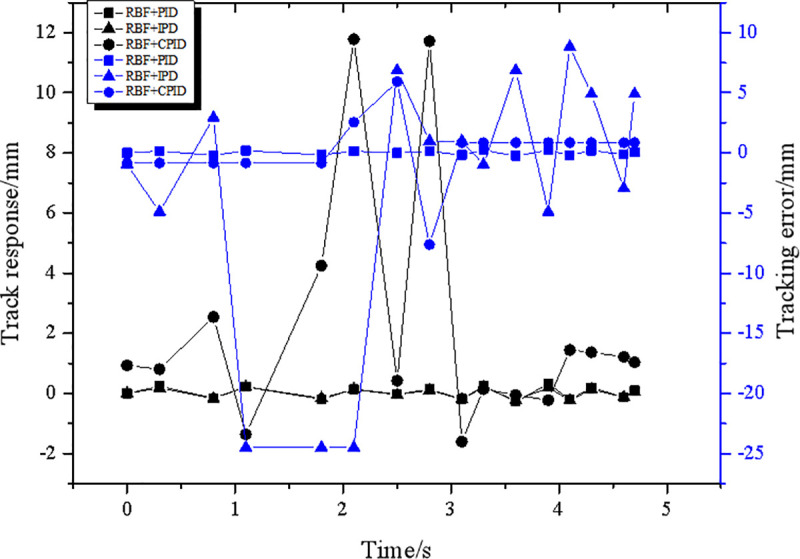
Tracking response and tracking error of the three control methods to the hybrid bearing system.